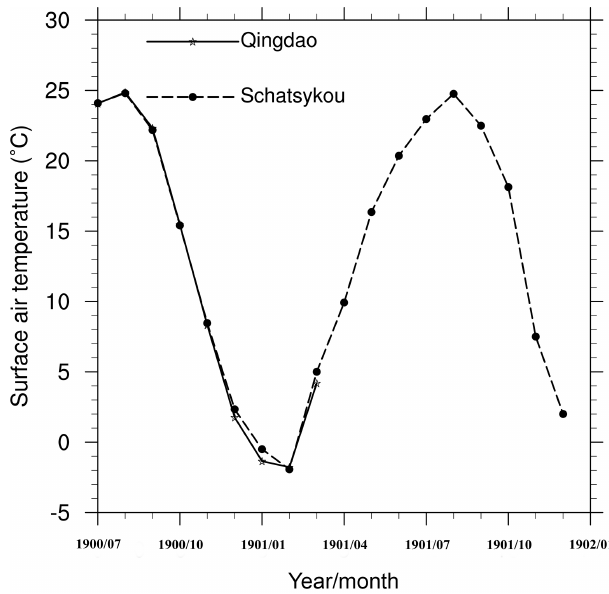
Figure 2. Comparison of the monthly mean SAT in Qingdao (solid line) with that in Schatsykou (dashed line) during July 1900 to De- cember 1901.